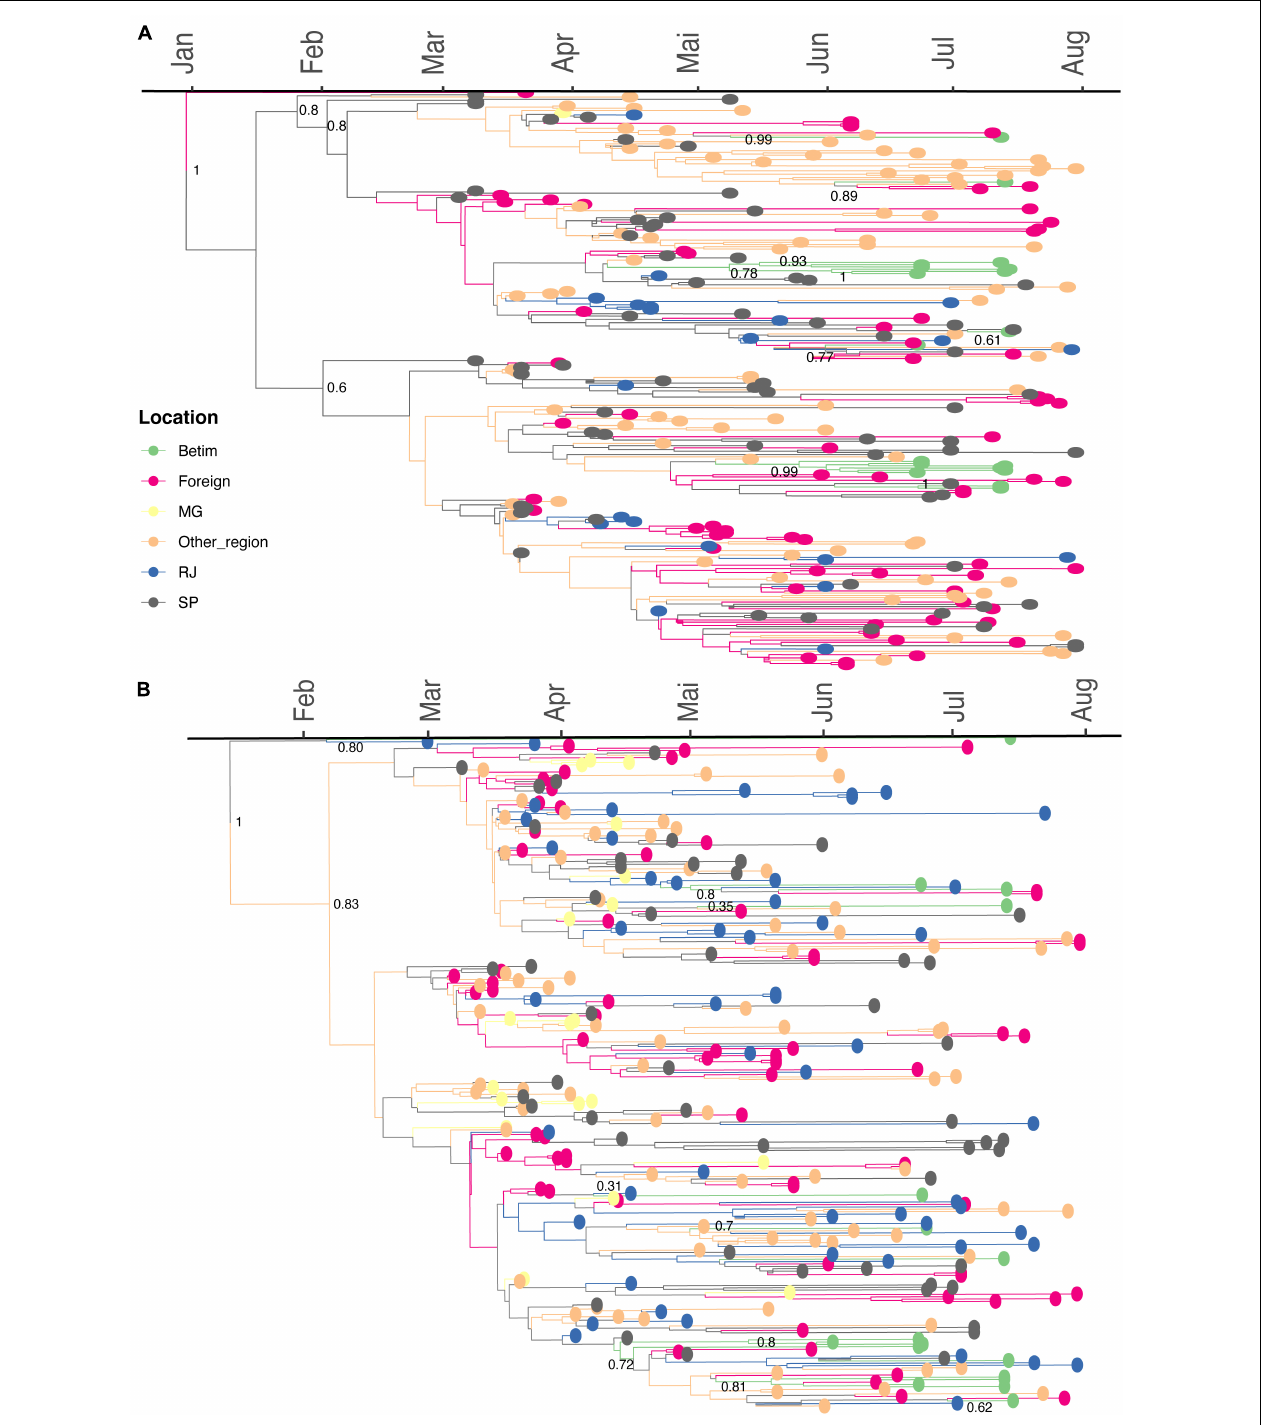
FIGURE 5 | Spread of B.1.1.28 and B.1.1.33 lineages in Betim city . (A) Time-resolved maximum clade credibility phylogeny from a dataset comprehending 240 publicly available B.1.1.28 sequences and the 18 genomes generated in this study. (B) Time-resolved maximum clade credibility phylogeny from a dataset including 267 publicly available B.1.1.33 sequences and the 17 genomes generated in this study. For both analyses, the HKY+I+G4 nucleotide substitution model was used. The diamond indicates sequences from Betim city obtained in this study. The trees inferred are available